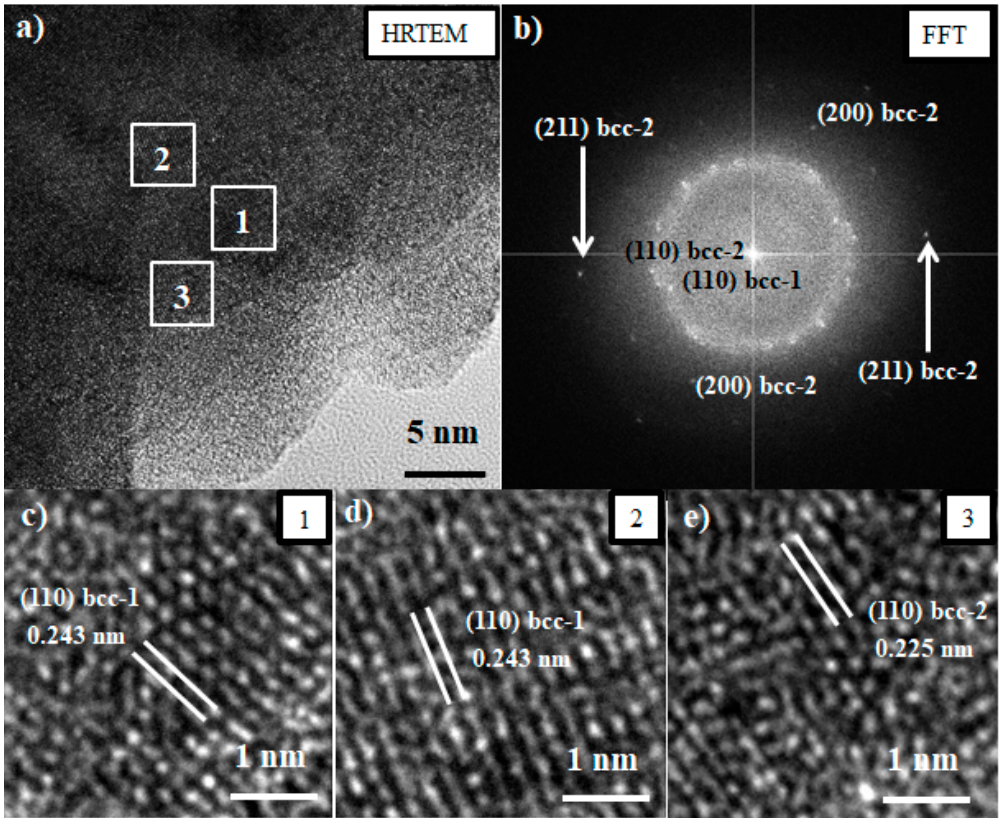
Figure 5. ( a ) High-resolution transmission electron microscopy (HRTEM) and ( b ) the corresponding fast Fourier transform (FFT) images for the pTNTMZ10h. Squares on the upper left images correspond to the magnification areas marked in the lower left HRTEM images. ( c ) Area no.1, ( d ) area no. 2 and ( e ) area no.